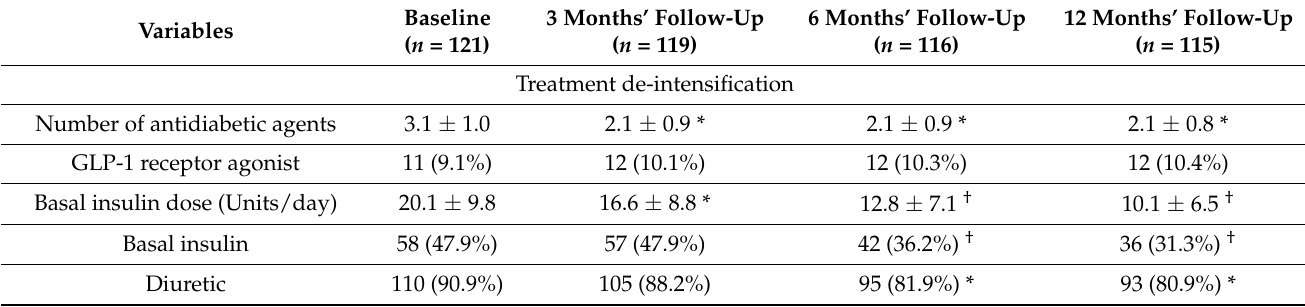
Table 2. Treatment de-intensification, glycemic control, anthropometric characteristics, heart failure health status, vascular risk, fatty liver disease, laboratory variables, adverse drug reactions, and major